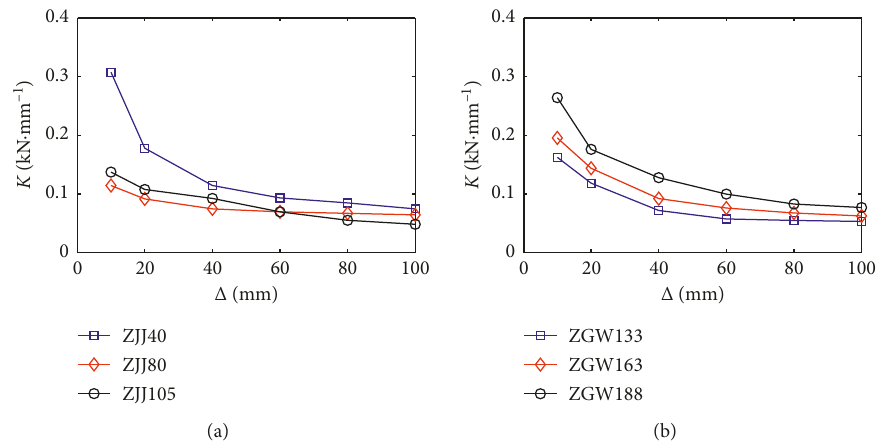
Figure 11: Stiffness degradation curves. (a) Unilateral column foot damage (ZJJ). (b) Circumferential column foot damage